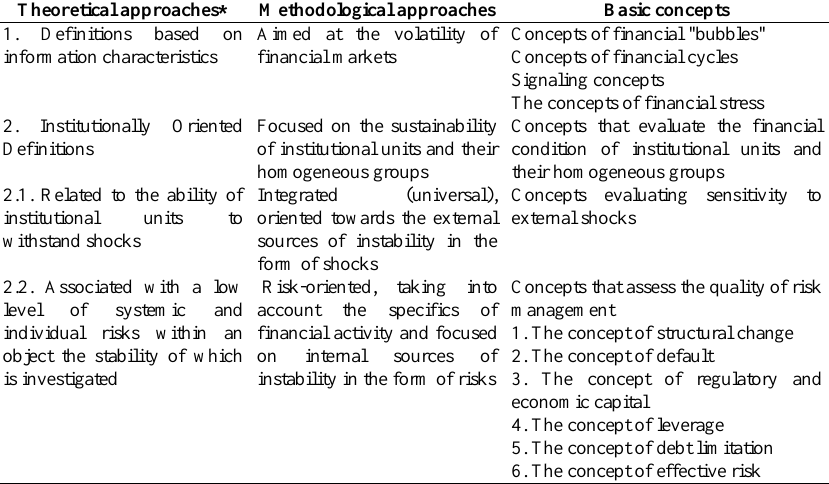
Table 1. Theoretical and methodological approaches to diagnosing the financial